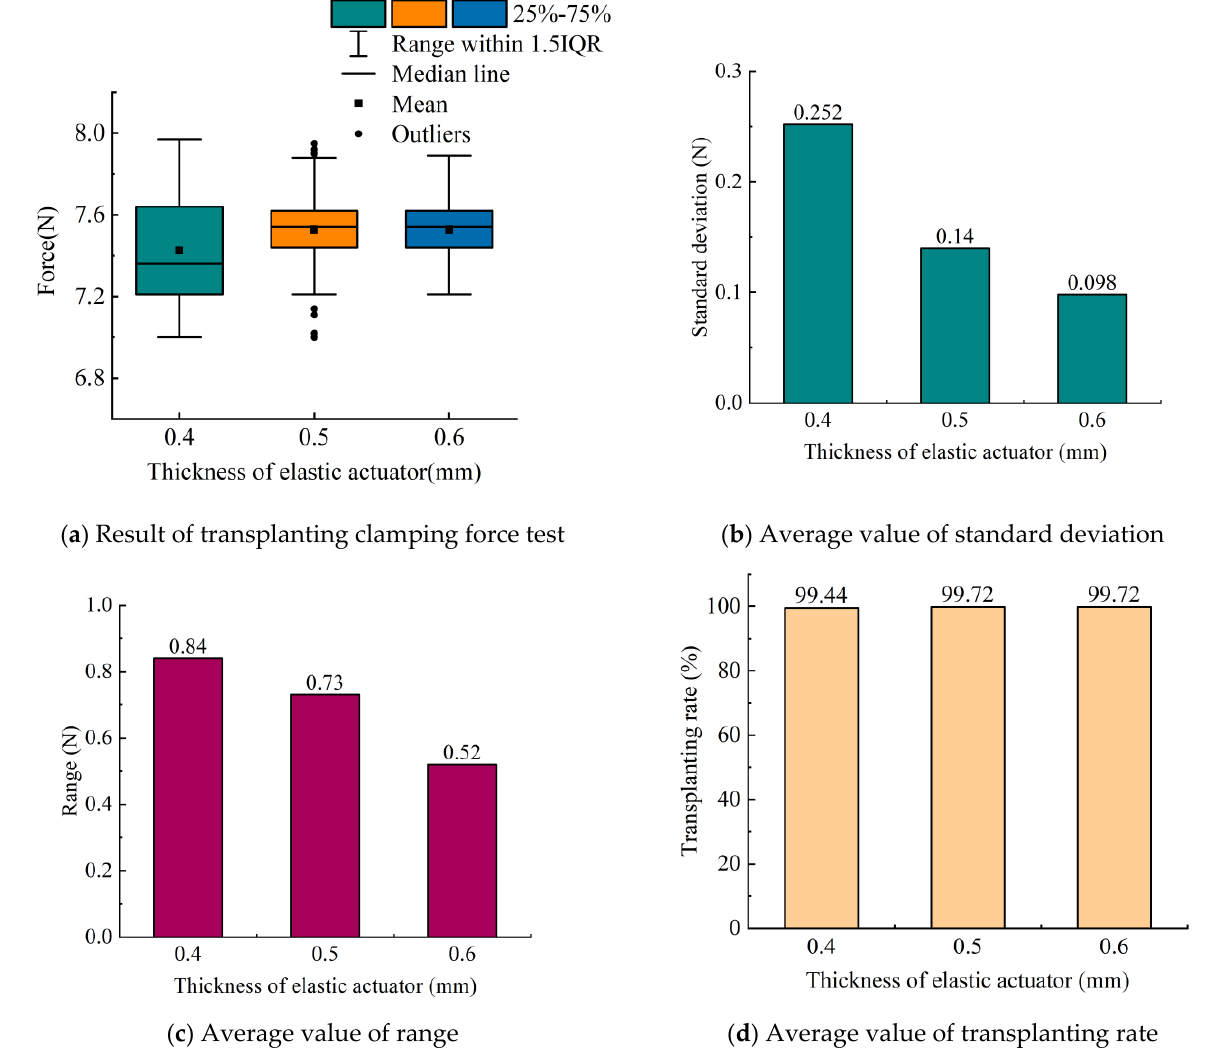
Figure 12. Results of seedling clamping force test under different thicknesses of elastic actuators: ( a ) box-plot of clamping measurement value; ( b ) bar chart of the average value of the standard deviation of clamping force; ( c ) bar chart of the average value of range of clamping force; ( d ) bar chart of the average value of transplanting rate.